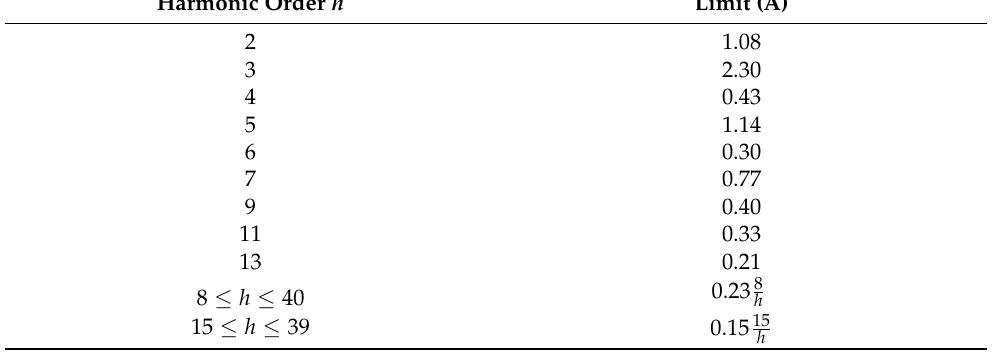
Table 1. Harmonic distortion limits as per Table 1 of IEC 61000-3-2 standard.